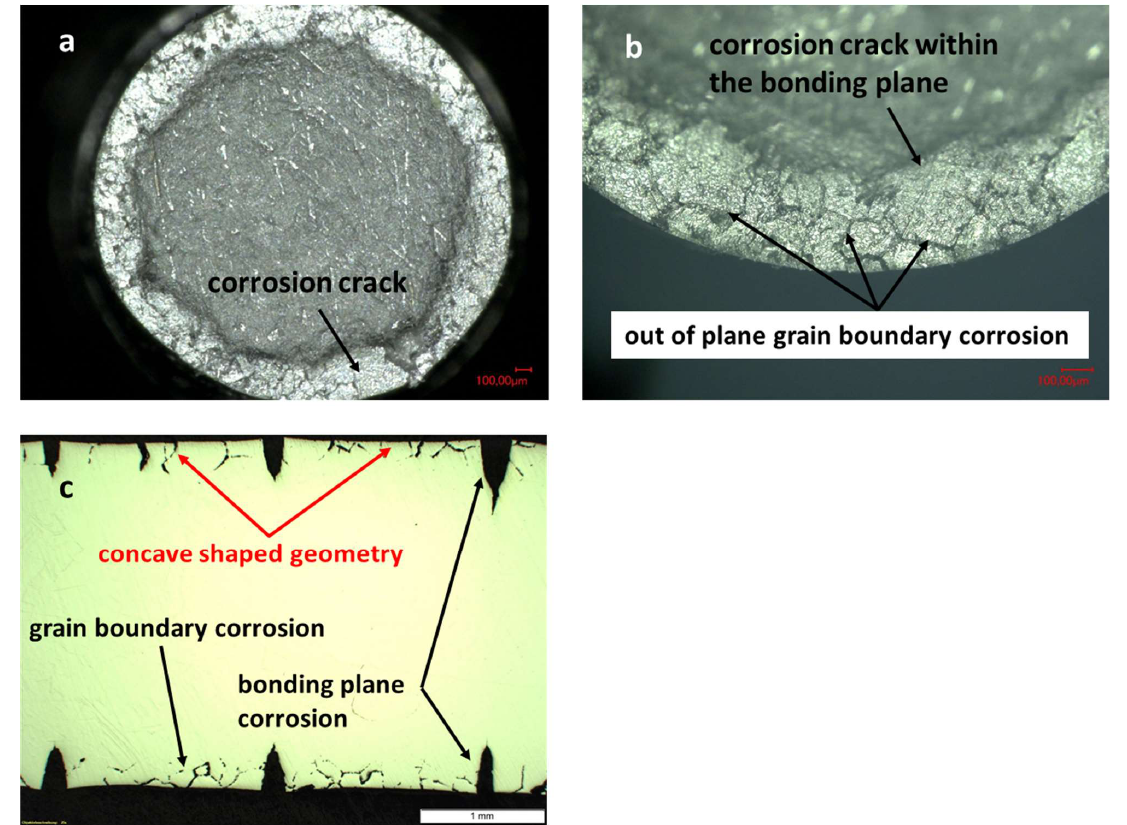
Figure 11. Micrographs of tensile tested diffusion bonded and aged (1000 h at 100 °C in 70% sulfuric acid) samples made of Hastelloy B3. ( a ): Overview of fracture surface displaying corrosion attack depth. ( b ): Border of corrosion attack depth and out of plane grain boundary corrosion. ( c ): Longitudinal cut along center of failed sample. Since no tensile forces can be transmitted to the depth of the corrosion